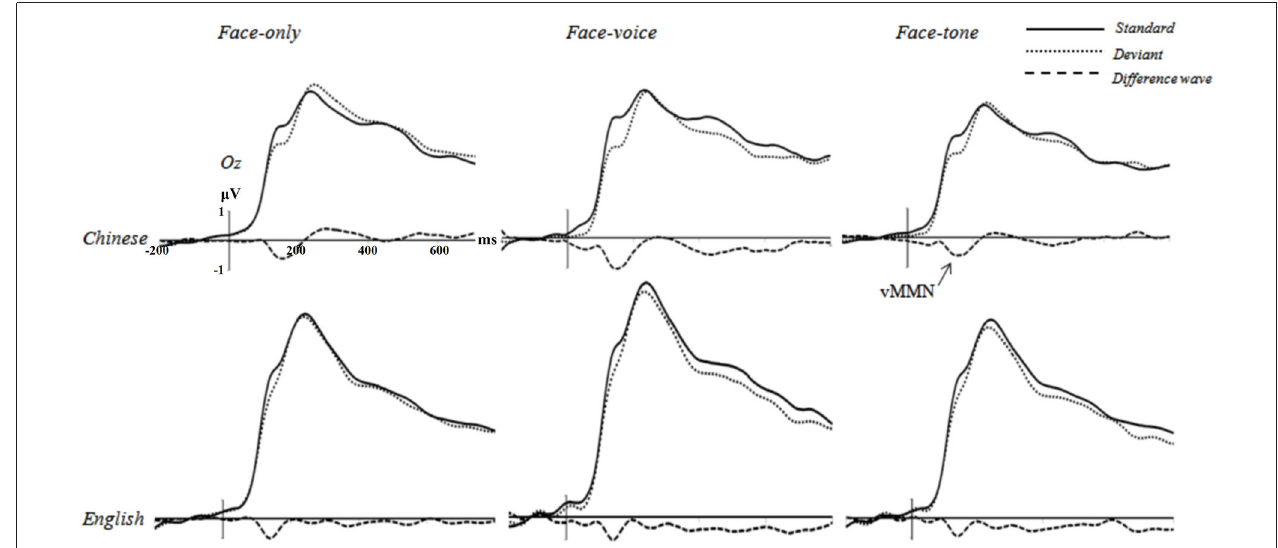
FIGURE 3 | Grand averages elicited by Standard trials (solid lines), Deviant trials (dotted lines), and the difference wave (dashed lines; Deviant—Standard) at Oz electrode for each condition of eachgroup (negative is plotted down)